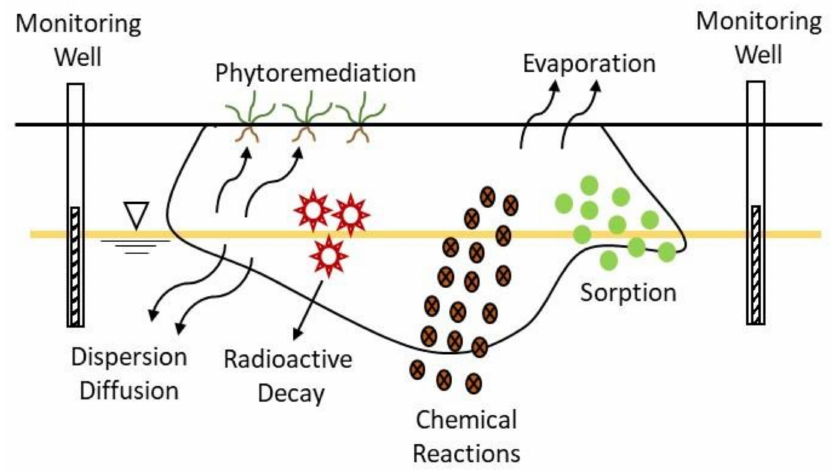
Figure 7. Mechanisms involved in the natural attenuation process